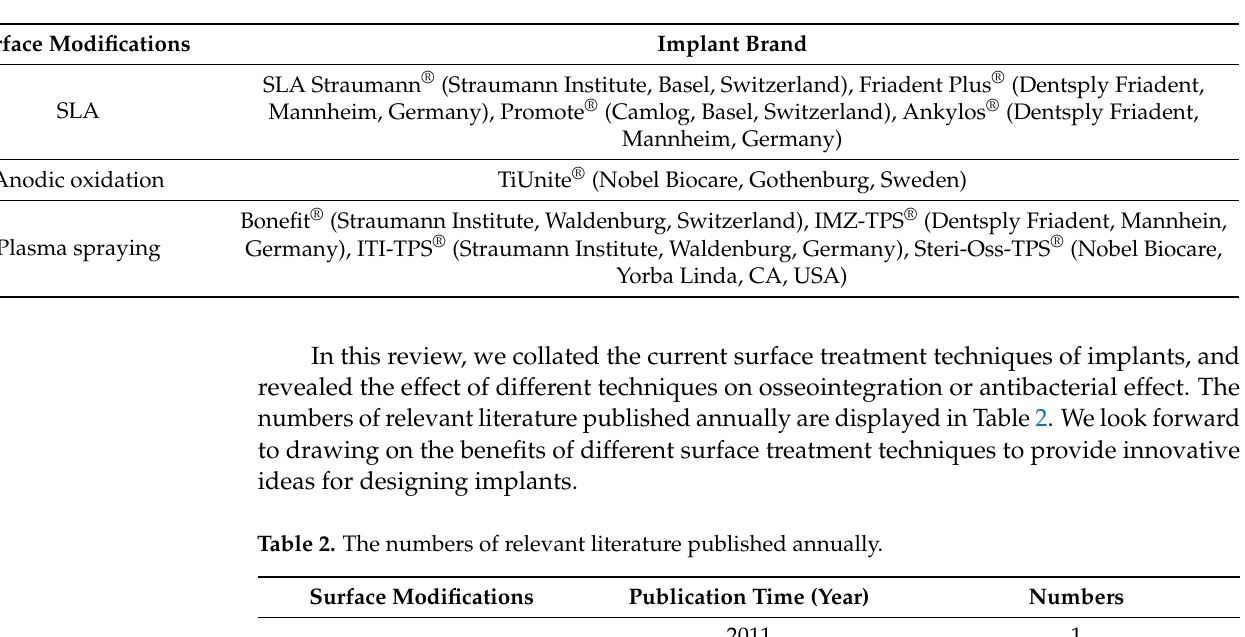
Table 1. Implant surface modifications used in commercial implants.